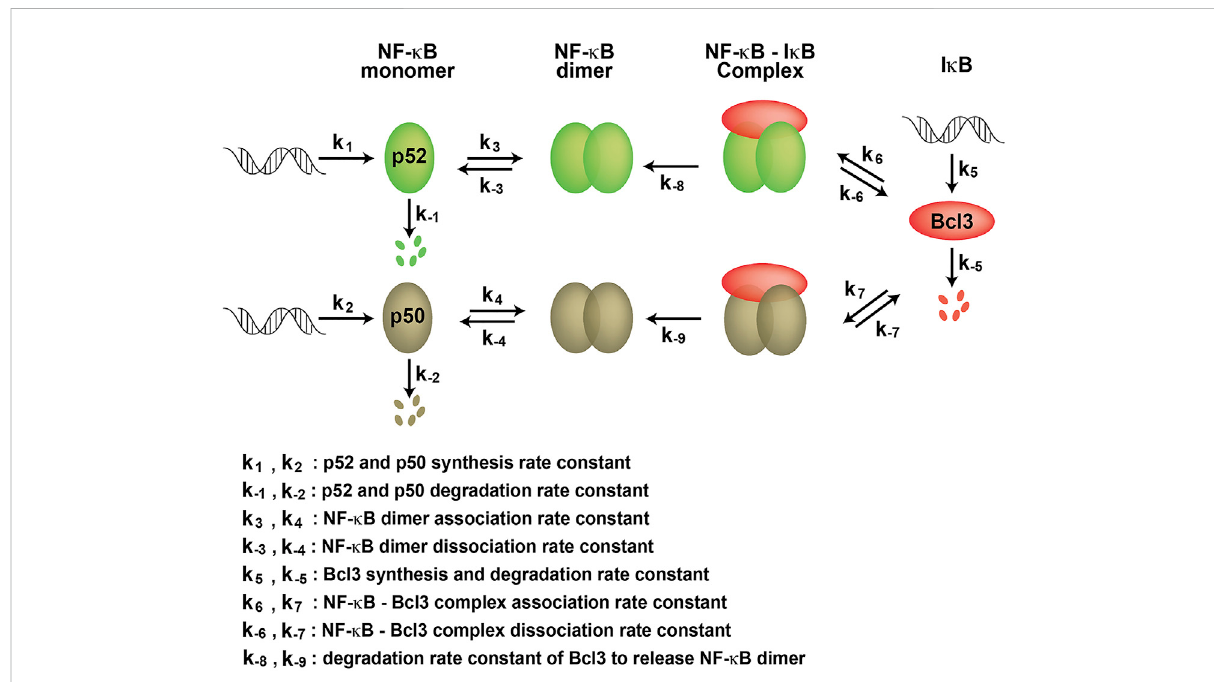
FIGURE 7 Kinetic model of NF- κ B dimer generation. k 1 and k 2 are p52 and p50 synthesis rate constants; k -1 and k -2 are p52 and p50 degradation rate constants, respectively. k 3 and k 4 are dimer association rate constants, while k -3 and k -4 are p52:p52 and p50:p50 dimer dissociation rate constants, respectively. k 5 and k -5 are the Bcl3 synthesis and degradation rate constants. k 6 and k 7 are the Bcl3-NF- κ B complex association rate constants; k